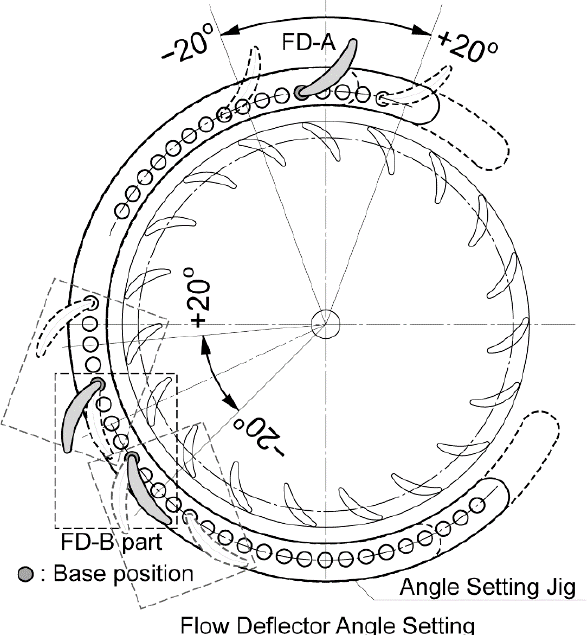
Figure 4. Inclination angle setting of three flow deflectors by jig and range of inclination angles for output performance test experiments.